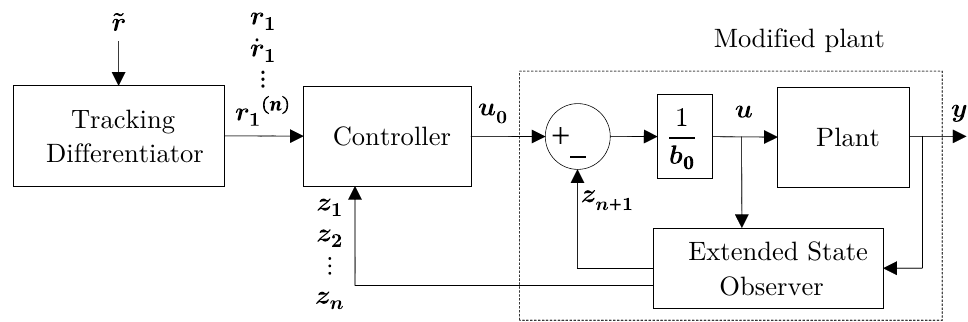
Figure 1. Active Disturbance Rejection Control (ADRC)